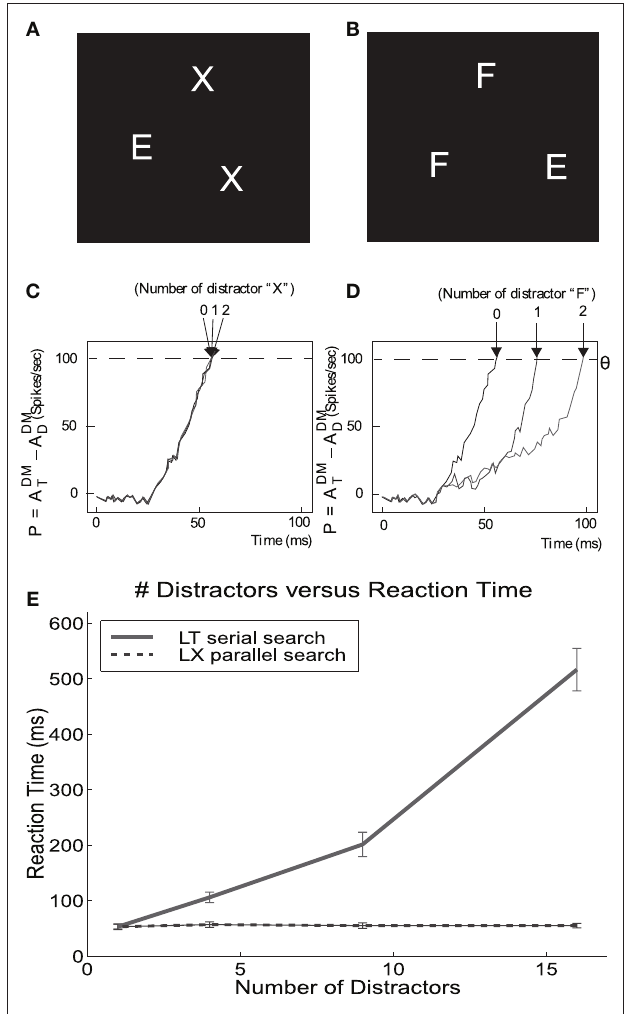
Figure 5 | Serial and parallel search emerge from the same mechanism. (A,B) Parallel and serial search stimuli, respectively. (C,D) Difference in the activation at the target location relative to the distractor locations as time evolves. The time required for this signal to cross threshold is assumed to be related to the time required by humans to find the target. The time required to find the E in X’s is constant while the time required to find the E in F’s increases linearly with the number of F’s. (e) The visual search experiment is repeated for other stimuli with a large number of distractors. Finding the L in X’s requires constant time (parallel), while finding the L in T’s increases linearly with the number of T’s (serial). DM, dorsal stream module. Figure modified from Deco and